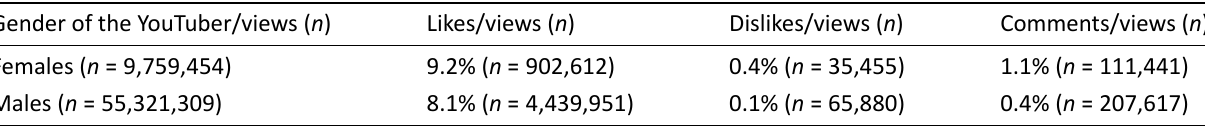
Table 2. Percentage of views vs. likes, dislikes, and comments by gender (2019–2020). Gender of the YouTuber/views ( n )